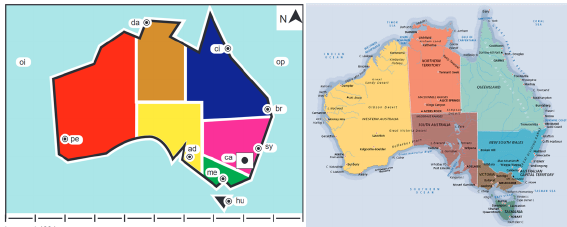
Figure 1: Two administrative maps of Australia: for visu- ally impaired people on the left ( c (cid:13) INSHEA-SDADV-2019- 2020); for people with normal vision on the right (source: